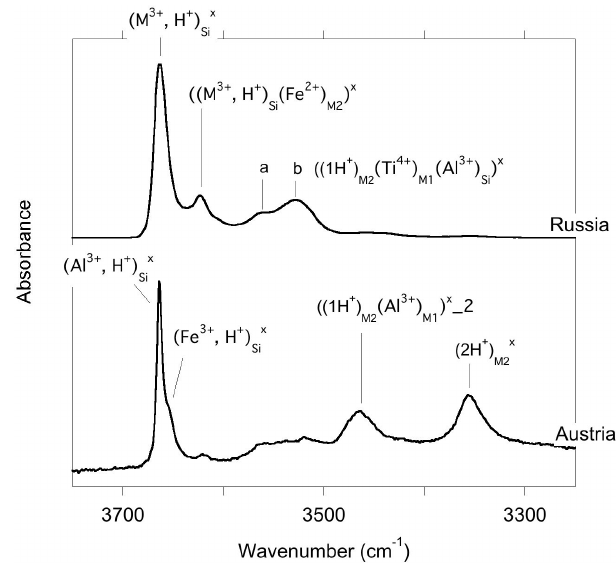
Figure 8. Band assignment in the low-temperature infrared spectra of Russian and Austrian diopside